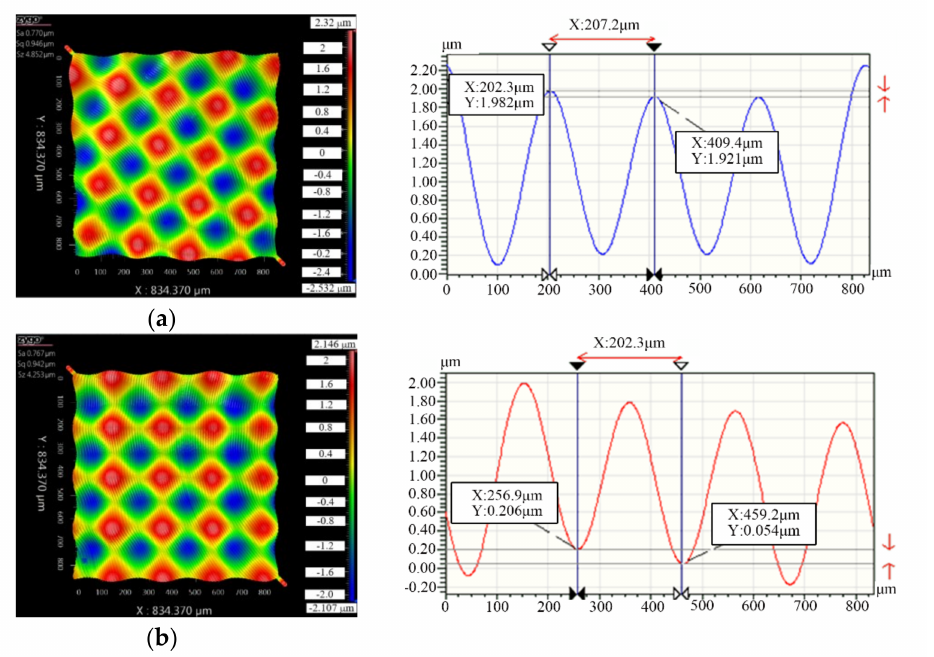
Figure 6. Effect of feed rate on profile of sinusoidal microstructures. Feed rate: ( a ) 8 µ m/r; ( b ) 5 µ